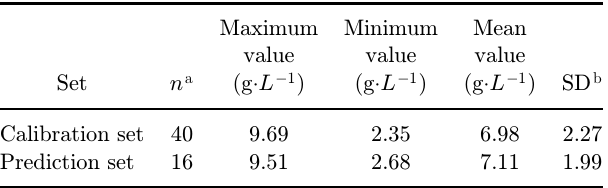
Table 2. The reference measurements and sample numbers in calibration set and prediction